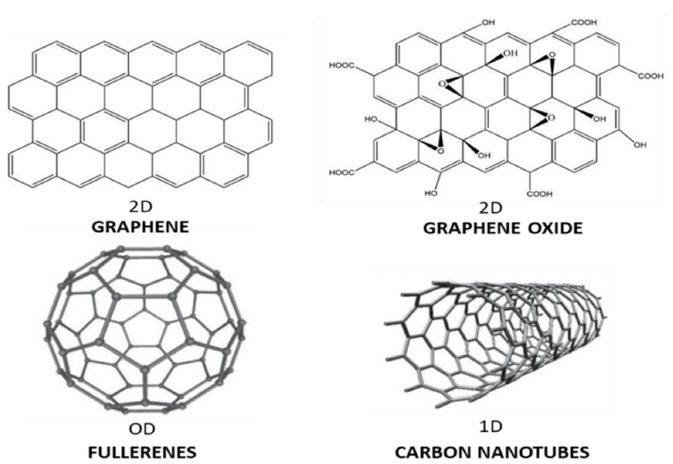
Figure 1. Schematic representation of carbon-based nanomaterials: 0D fullerenes, 1D carbon nan- otubes (CNTs), 2D graphene (G), and graphene oxide